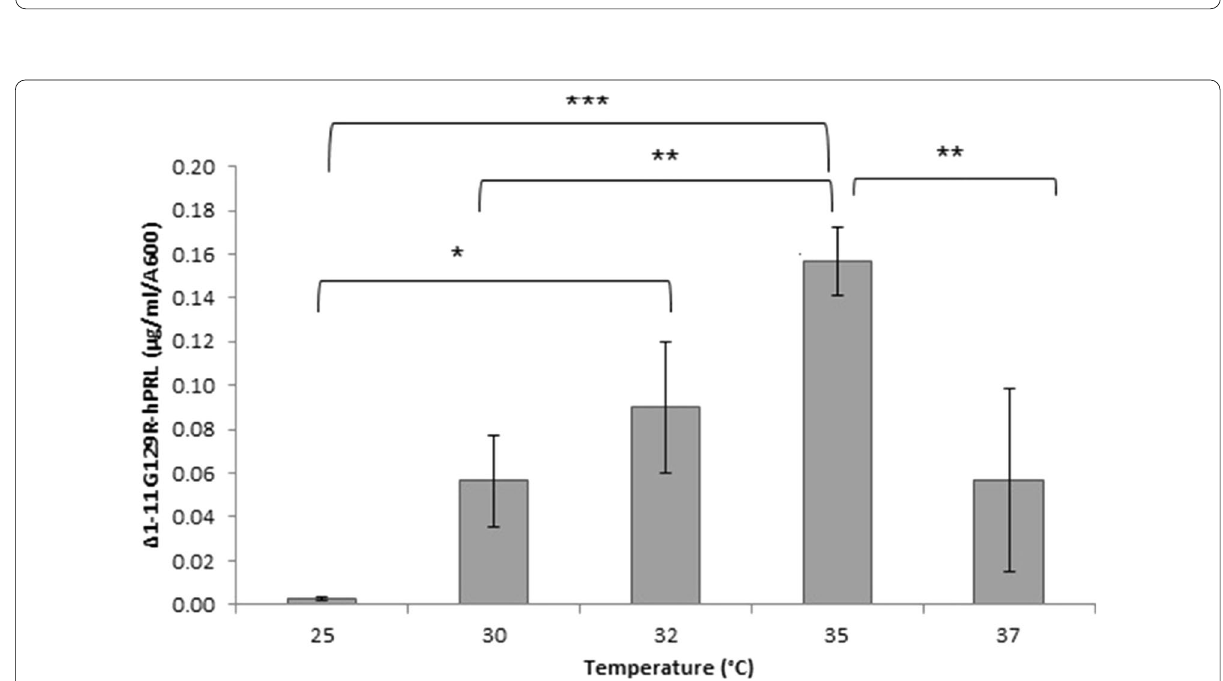
Fig. 2 Influence of the temperature on Δ 1-11 -G129R-hPRL synthesis (n *P < 0.05, **P < 0.01, ***P <